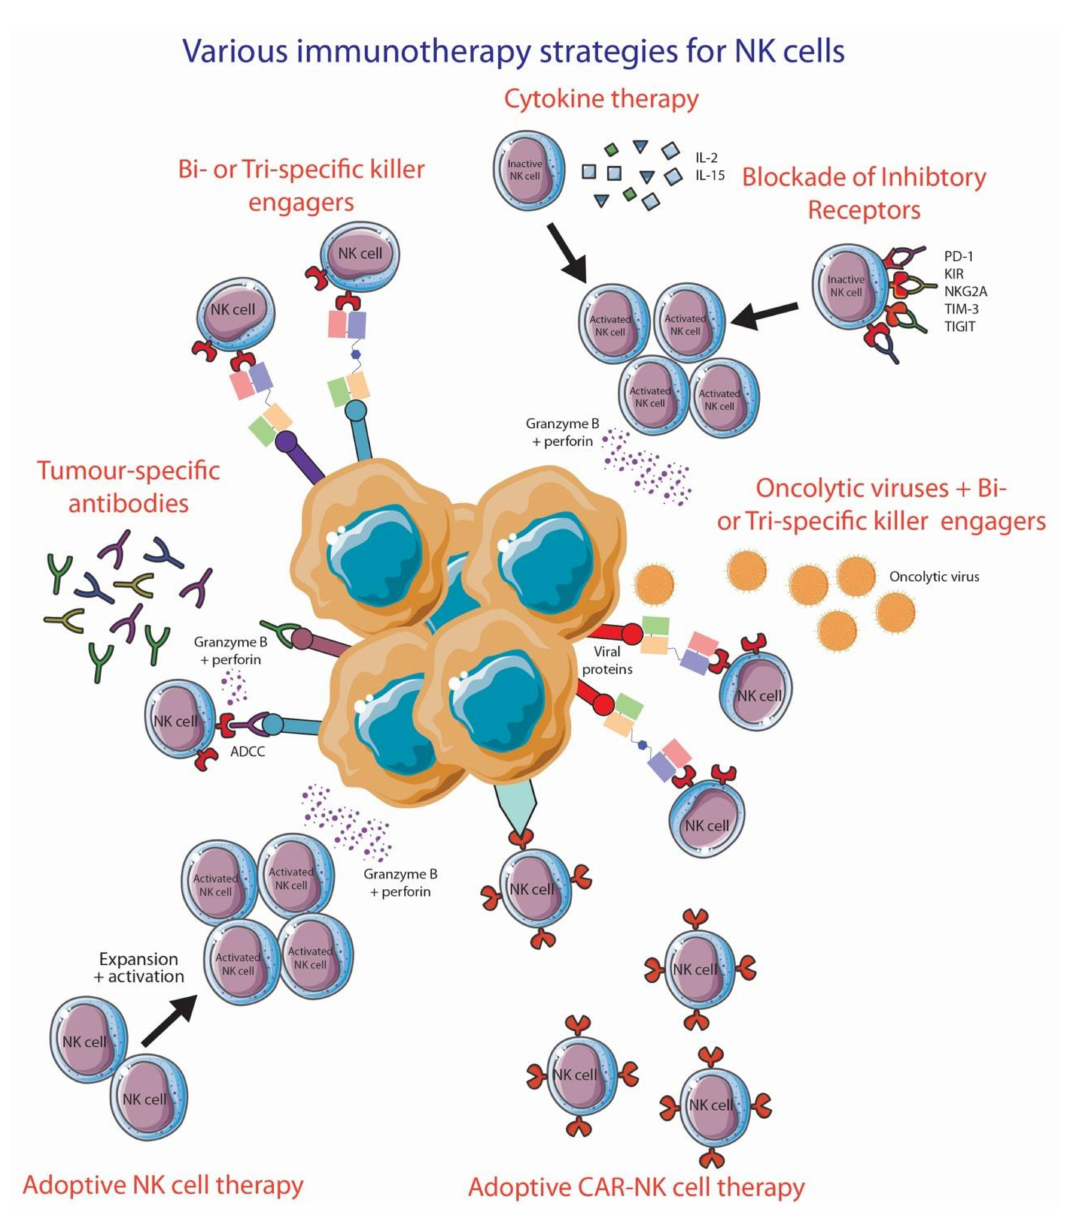
Figure 4. Various immunotherapy strategies to improve NK cell functionality. This figure was created using Servier Medical Art templates, which are licensed under a Creative Commons Attribution 3.0 Unported License; https://smart.servier.com (accessed 10 October